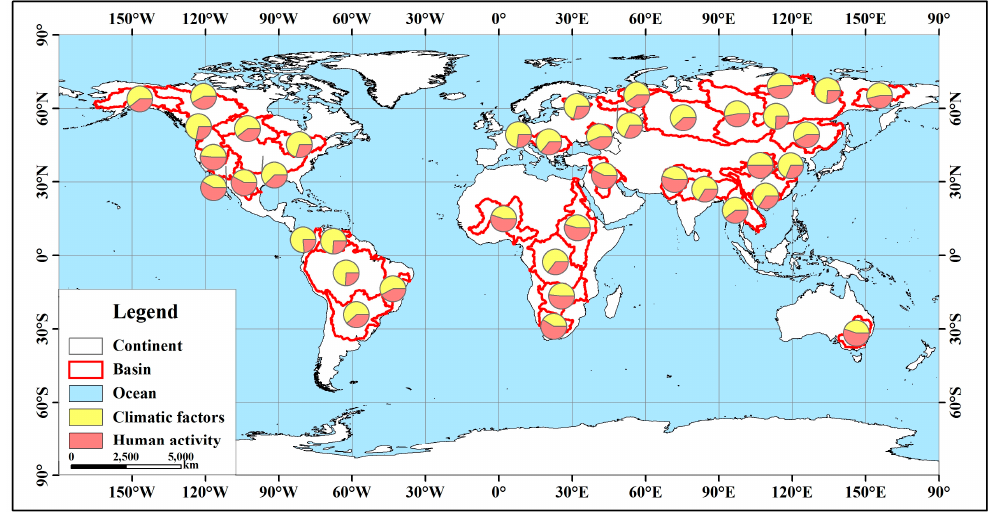
Figure 7. Distribution of the influencing factors of the discharge variation in each basin.